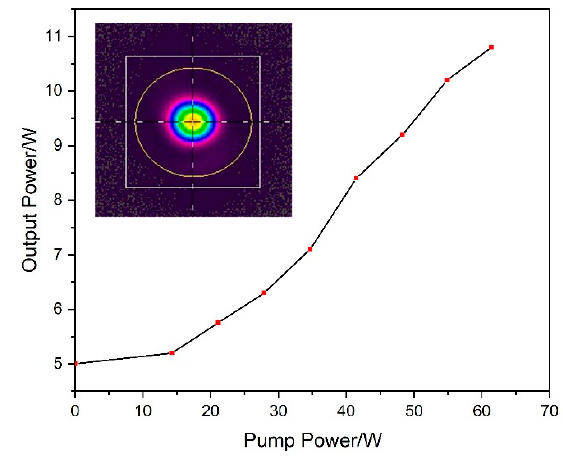
Figure 4. Power curve and beam image of end-pumped single-pass amplifier.